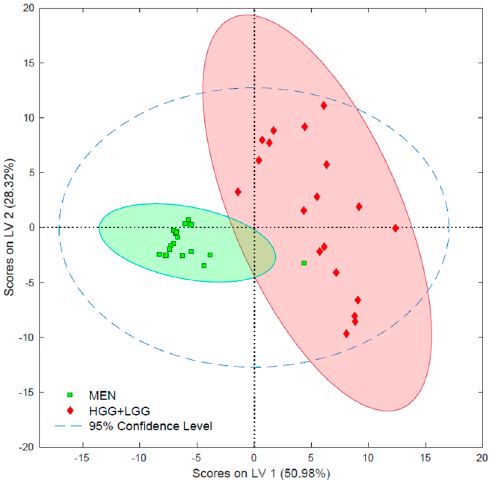
Figure 3. Chemometric analysis of meningiomas and gliomas—partial least squares data analysis (PLS-DA) performed on all detected features with a VIP above 1.0.